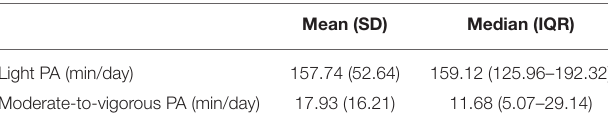
TABLE 2 | Time spent in light and moderate-to-vigorous activity ( n = 58).